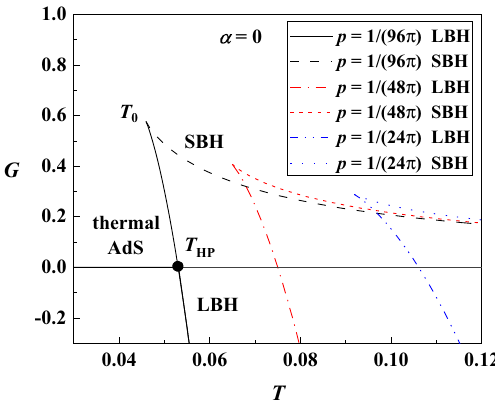
Fig. 2 The entropies of the Schwarzschild–AdS black holes as a func- tion of temperature (LBH and SBH stand for large and small black holes). The large black holes have positive heat capacities and are thermodynamically stable, and small ones are on the contrary. At a given pressure p , the black hole temperature has a positive minimum, √ T 0 = 2 p /π